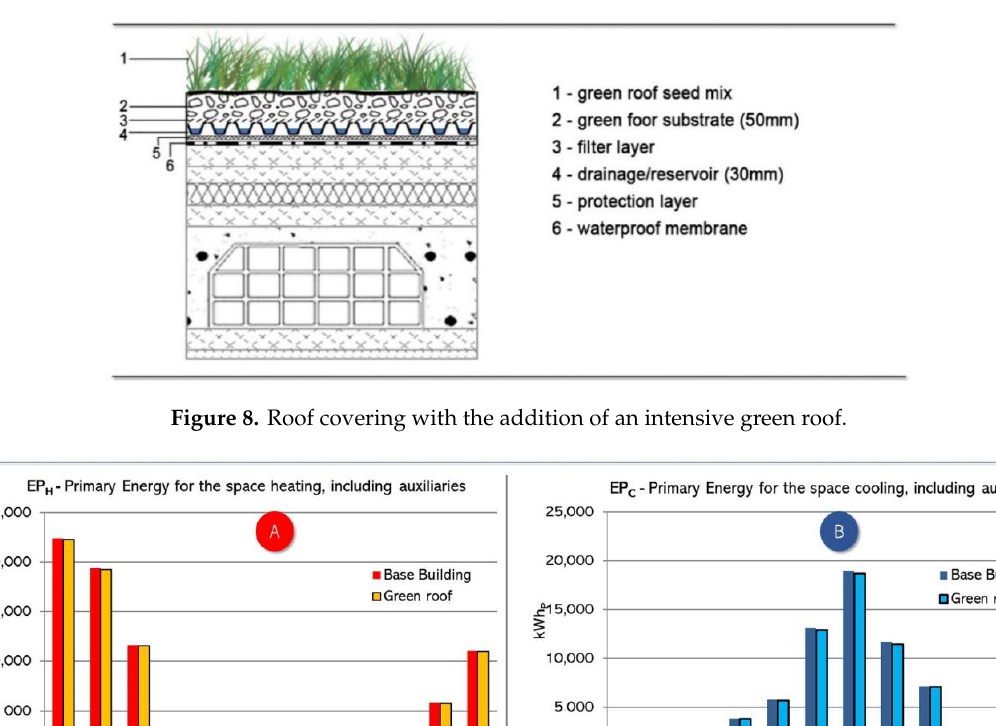
Figure 8. Roof covering with the addition of an intensive green roof.